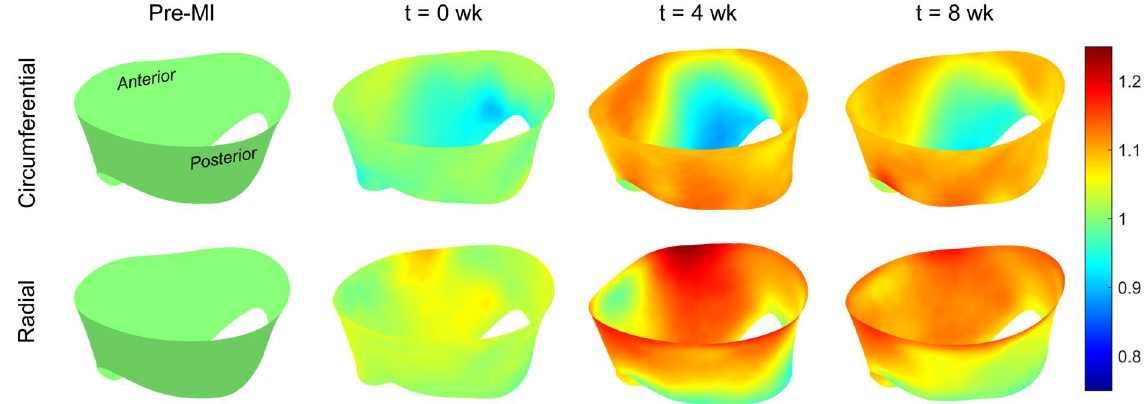
Figure 3. 3D MV geometry showing the average diastolic permanent directional stretch fields at each post-MI time point, referenced to the pre-MI diastolic configuration. As the post-MI remodelling process continued, the MV underwent increasing plastic deformation, with further increases ceasing after 4 weeks. These “deformation” patterns are a result of permanent changes in the opened shape of the MV, and should be distinguished from systolic strains that are driven by systolic pressure when the MV is closed.